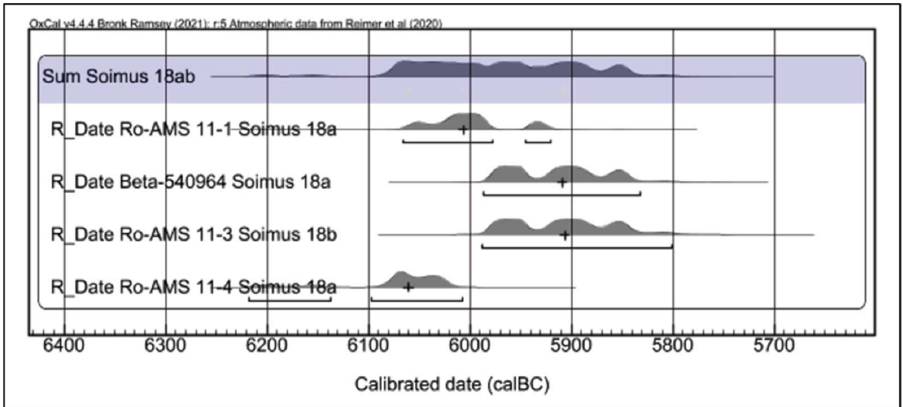
Figure 5. Calibrated AMS data for the features C.18a and C.18b—site Şoimuş-Teleghi .